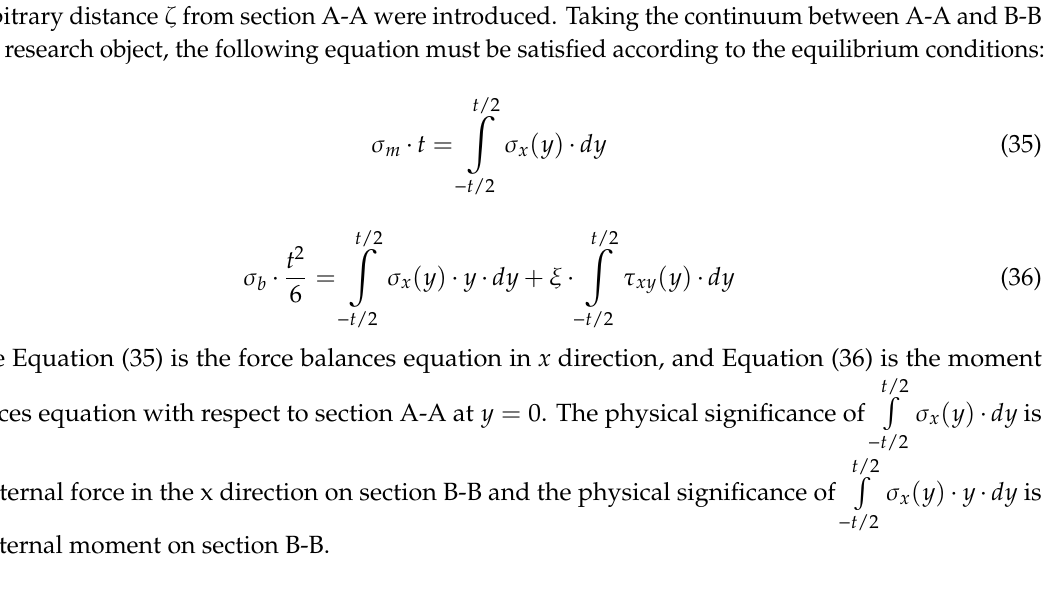
Figure 2. Through-thickness stress distributions in section B-B .